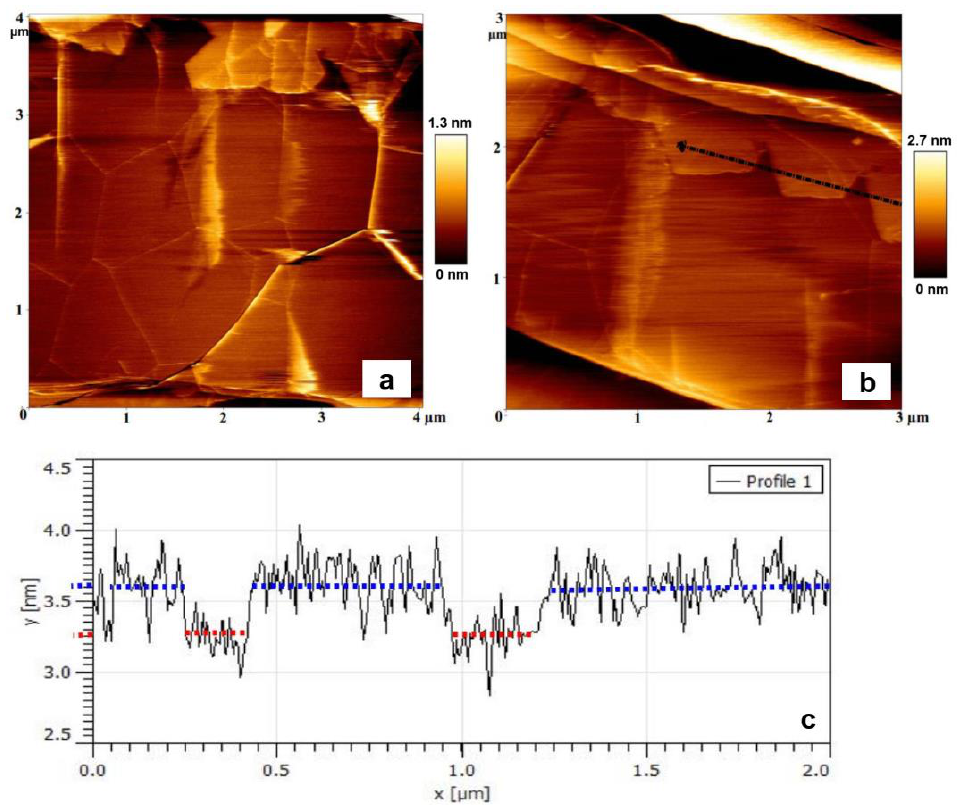
Figure 5. ( a ) Image of 4 × 4 µm 2 surface of the sample StGr-5 showing hexagonal structures. Both sets of lines that were described above, in Figure 4, are forming a hexagonal network over the surface of a terrace. Hexagons are replaced by pentagons or heptagons in some places as structural defects; ( b ) image of a 3 × 3 µm 2 area, both showing a hexagonal network as well as a growth front with a newly forming sub-hexagonal structure. The arrow indicates the trace of the profile-line that is shown below; ( c ) profile line taken over the boarder-zone of a newly forming hexagonal growth front of a sample grown on the C-polar face of SiC. The red and blue dashed lines indicate the average height of the terrace and the overgrowing growth-front.